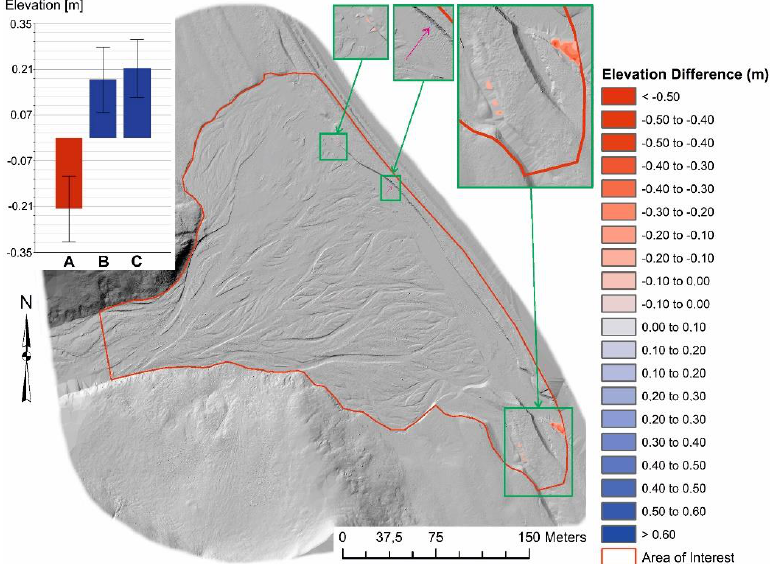
Figure 6. DEM of difference (DoD) for the AoI (August 2013 with MinLoD = 0.1). Hillshade map is shown behind the DoD for context. Description of the bars in the diagram: (A) Average Depth of Lowering; (B) Average Depth of Raising; (C) Average Total Thickness Difference.